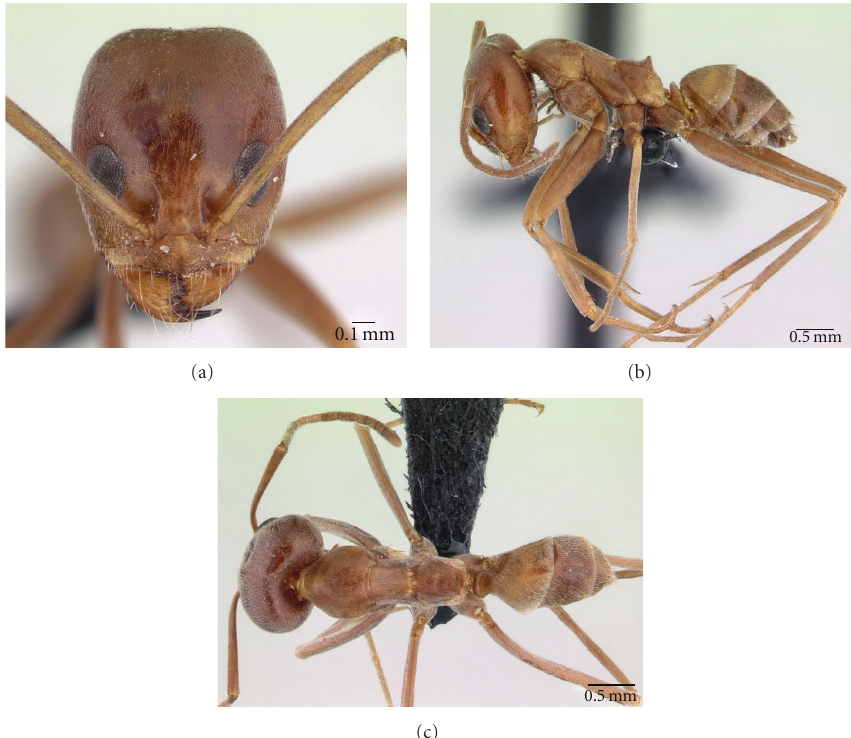
Figure 1: Dorymyrmex amazonicus n. sp. worker, holotype. (a) Head in full-face view; (b) body in lateral view; (c) body in dorsal view (CASENT0192703). Pictures and labels of localities of each photographed specimen are available at